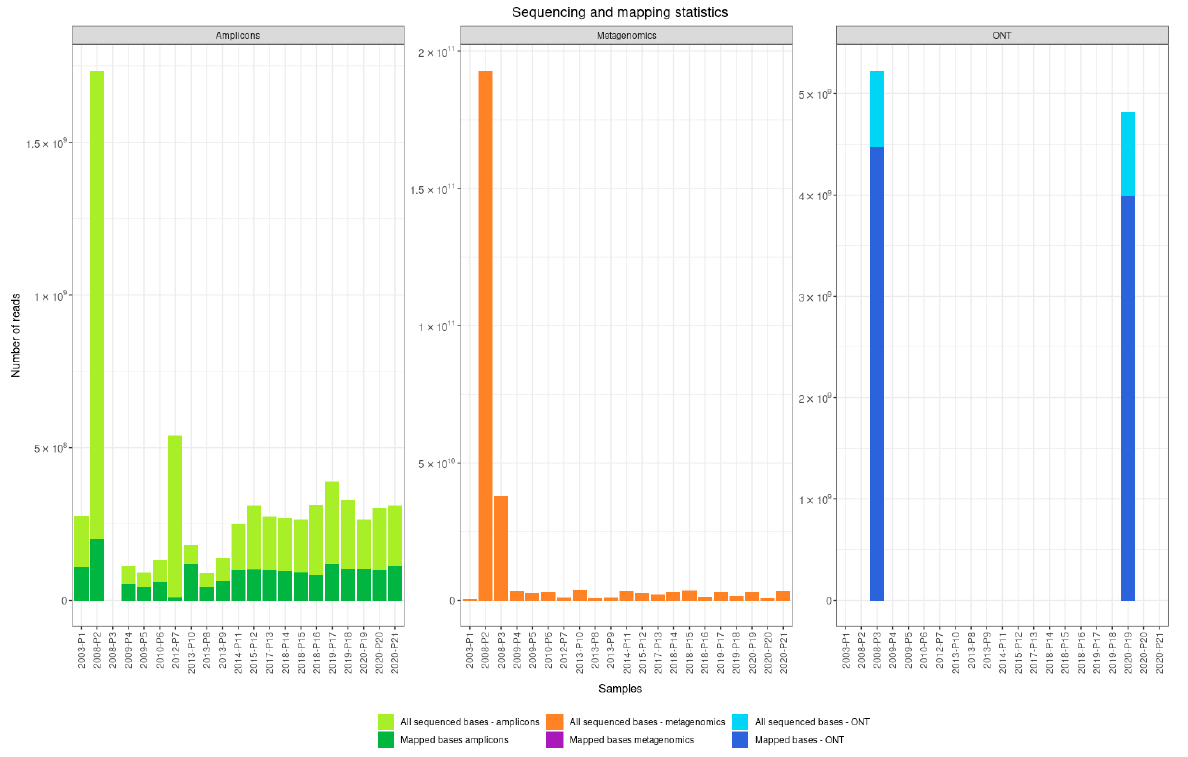
Figure 1. Sequencing and mapping statistics for clinical samples sequenced with amplicon-based and shotgun metagenomic sequencing on Illumina and Oxford Nanopore Technologies platforms. Note the difference in scales on Y axes between the approaches due to difference in number of generated reads.